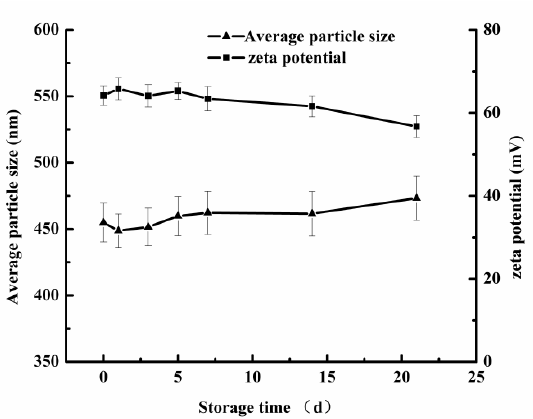
Figure 6. The particle size and zeta potential of secondary emulsion after 21 days storage.